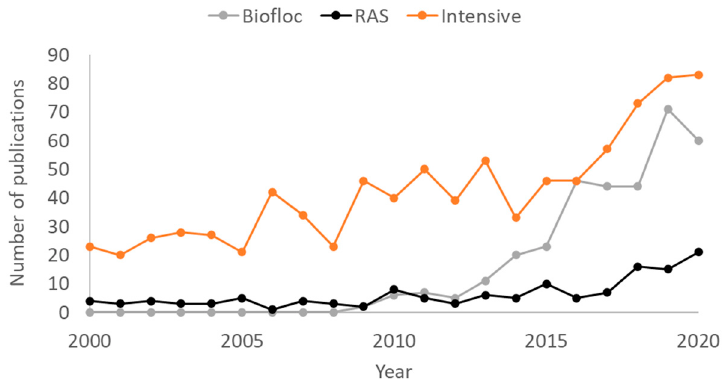
Figure 1. Bibliometric analyses of the evolution of scientific studies on penaeid intensification (using the combined search terms “Shrimp + biofloc”, “Shrimp + RAS” and “Shrimp + intensive”, in Scopus website).